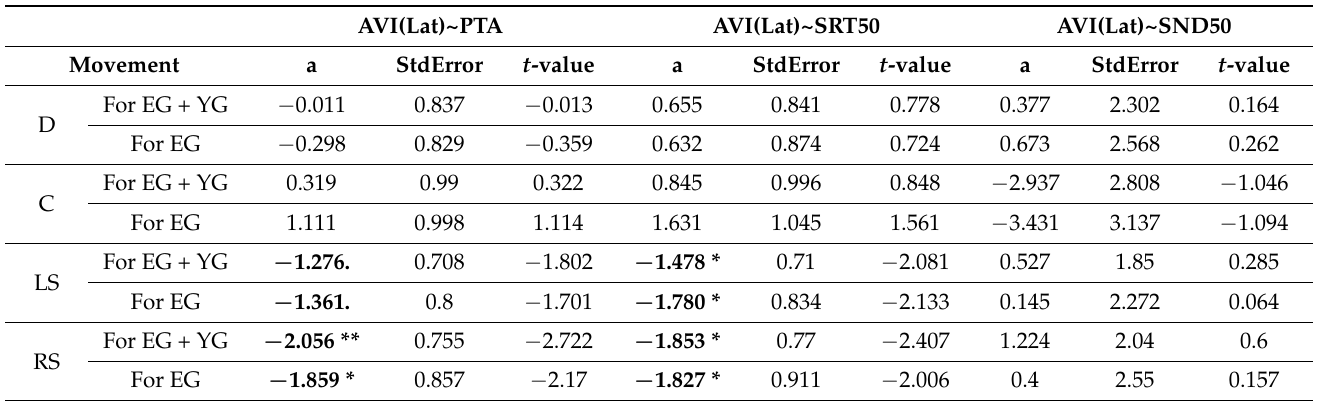
Table 4. Relations between AVI(Lat) and